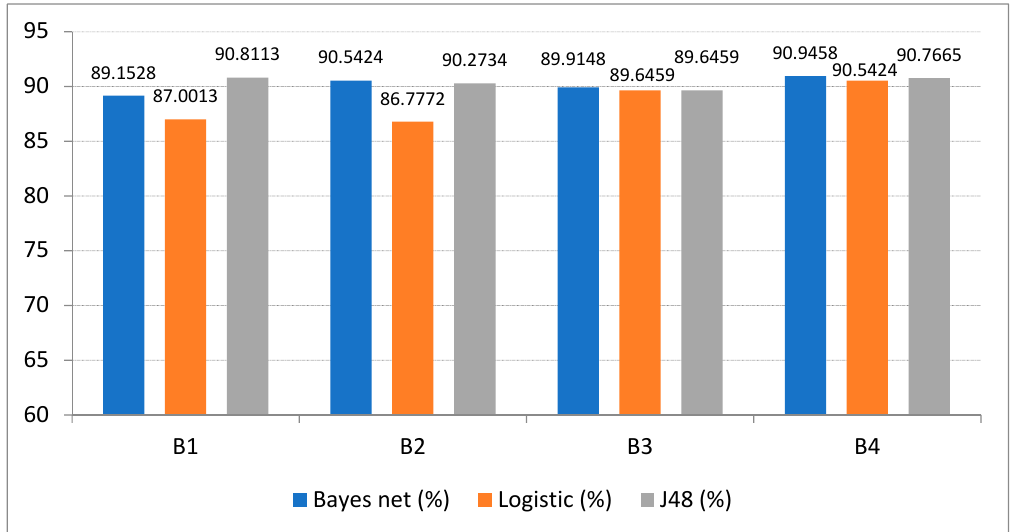
Figure 5. Models B1-B4 net profit decision (statistical graph). Results of Experiment 2: